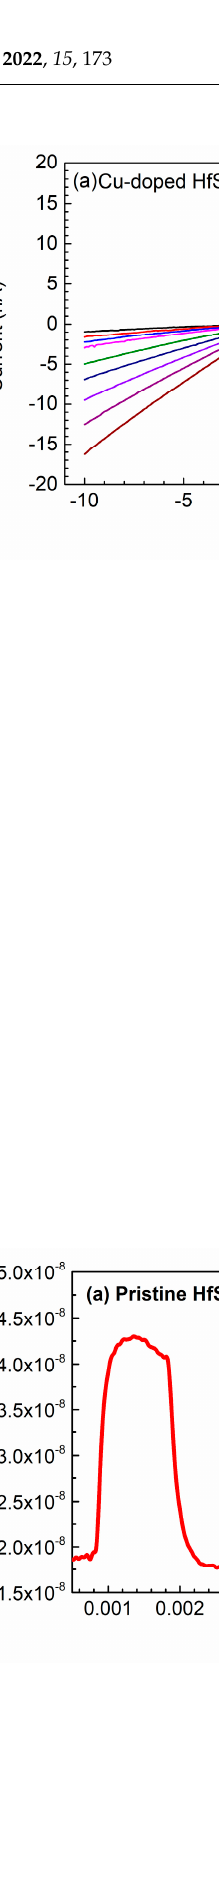
129 Table 5. Current amplitudes of the pristine, Mn-, Fe-, Co-, and Cu-doped HfS 2 crystals under dif- ferent illumination frequencies.